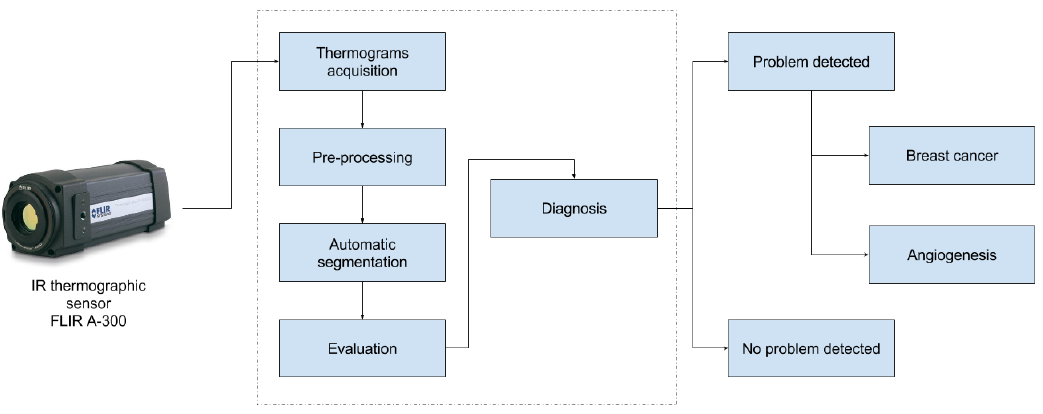
Figure 1. Proposed methodology.